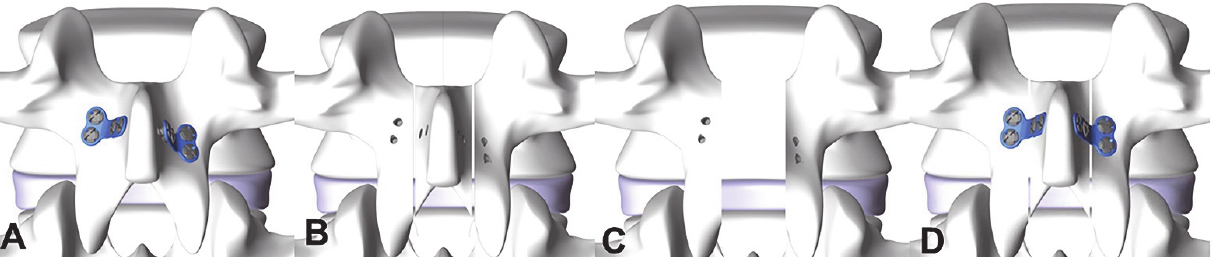
Figure 1. Procedures for resection and replantation of the spinous process and lamina complex. ( A ) The microplates were prefixed on the lamina and spinous process on both sides of the target plane; ( B ) the prefixed microplates and screws were removed, and laminectomy was performed using an ultrasonic osteotome; ( C ) the spinous process and lamina complex were removed and the tumor was resected; and ( D ) the spinous process and lamina complex were reduced and fixed with microplates. Finally, the supraspinous ligament at the head and tail of the lamina was sutured. The inclusion criteria were: (1) patients with intradural tumors who received op- eration for the first time; (2) patients with no spinal structure destruction or instability; (3) patients with complete clinicopathological data; and (4) patients who were followed up for at least one year. The exclusion criteria were: (1) patients whose facet joint was destroyed; (2) patients with recurrent tumors; and (3) patients whose lesions had caused spinal destruction and instability. All patients were followed up for at least one